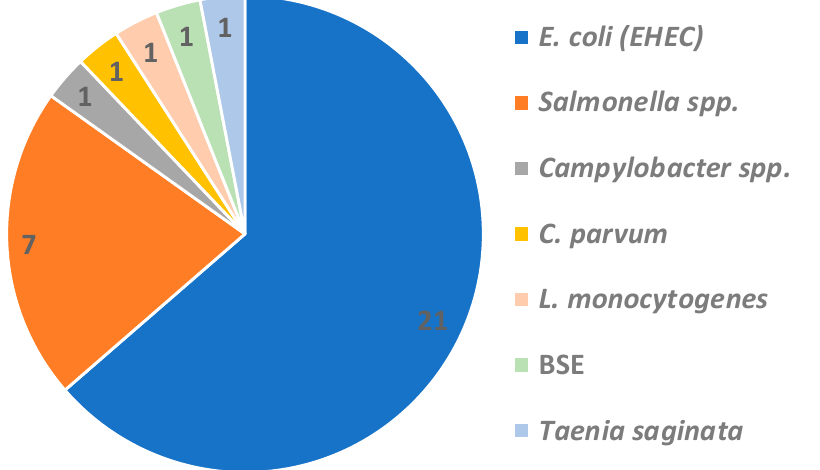
Figure 2. Pathogens considered in beef QMRA. EHEC: Enterohemorrhagic E. coli ; BSE: Bovine Spongiform Encephalopathy.